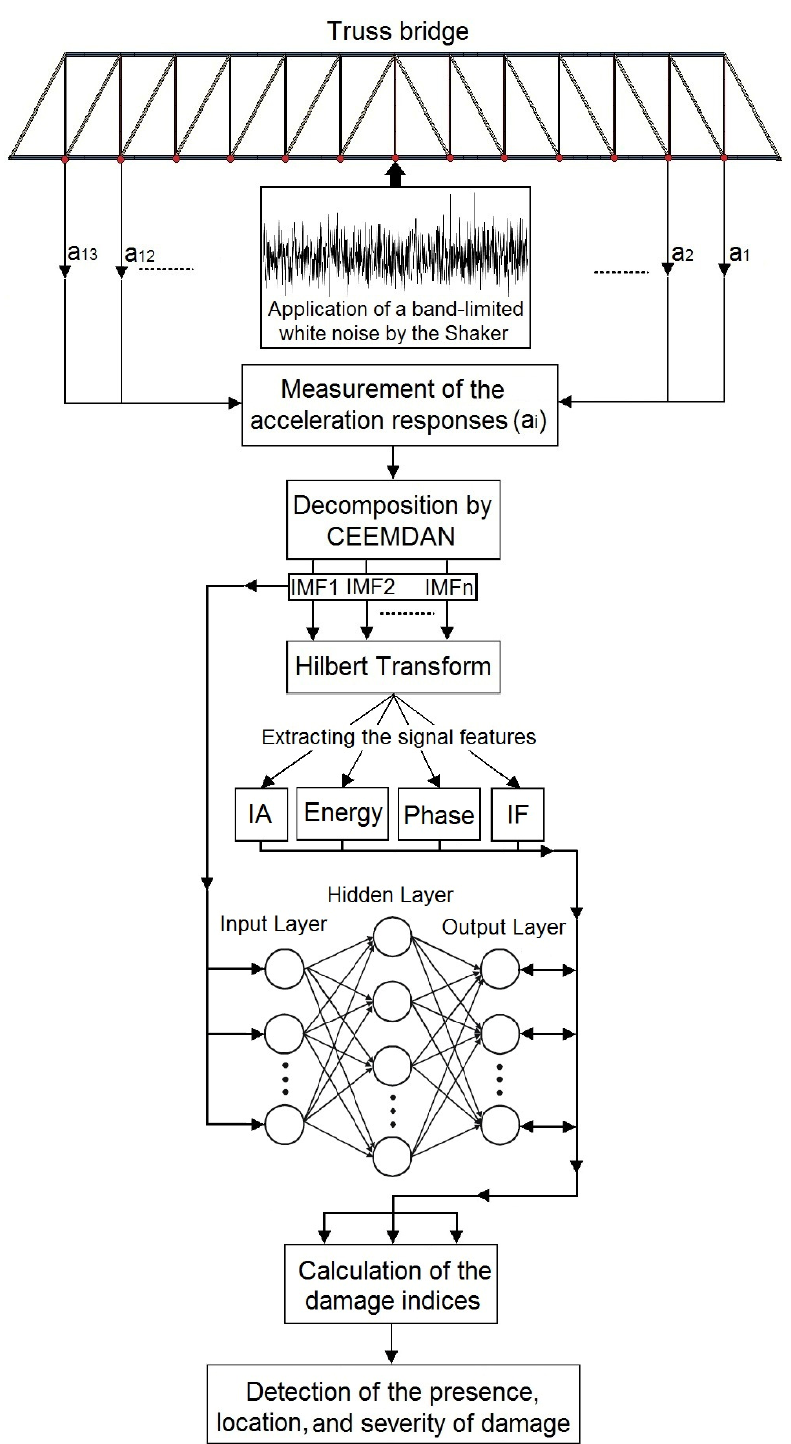
Figure 5. The framework flowchart of the proposed CEEMDAN-HT-ANN model to detect, locate, and classify the severity of the damage.